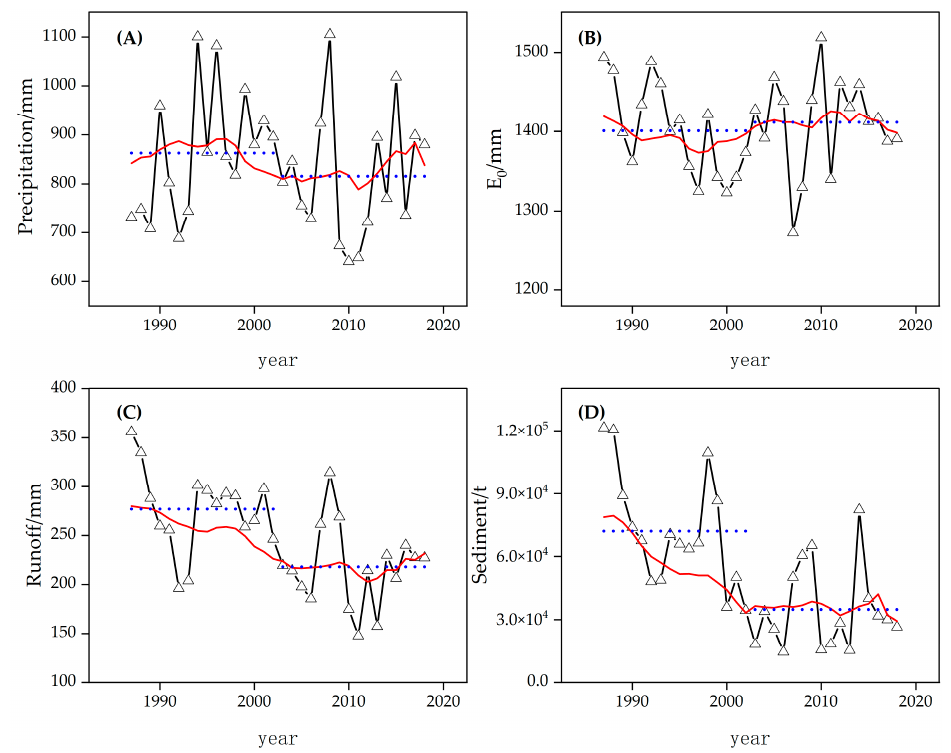
Figure 3. Changing trends of hydrological and meteorological characteristics of the NURS: ( A ) pre- cipitation, ( B ) E 0 , ( C ) runoff, and ( D ) sediment. The black curve is the annual change point plot, the red curve is the 11-year window moving average, and the blue dot is the mean before and after the change. Each hollow triangle has annual values for hydrological and meteorological data.